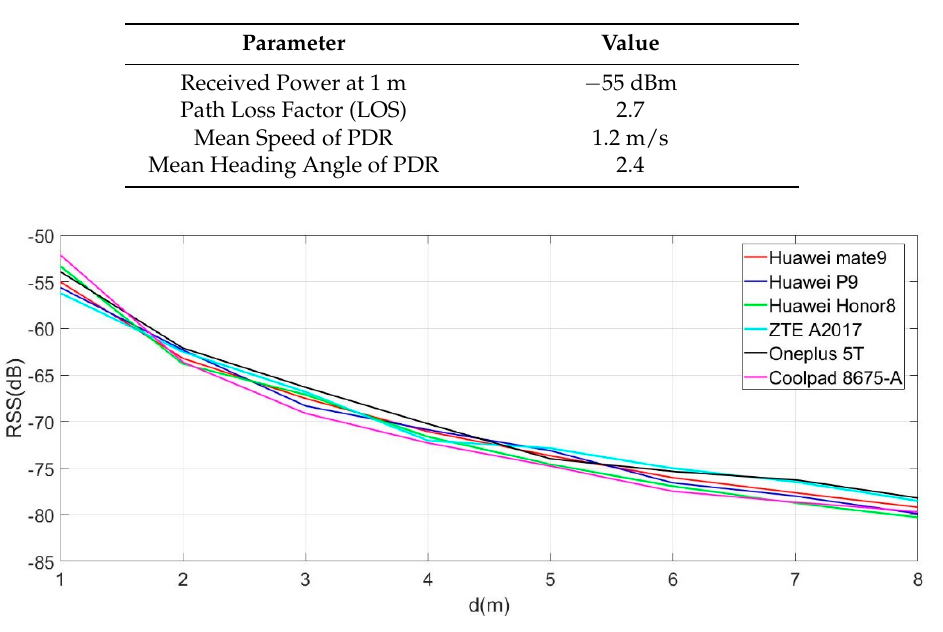
Table 3. The parameter values for evaluating the performance of our proposed methods collected by Huawei Mate 9.